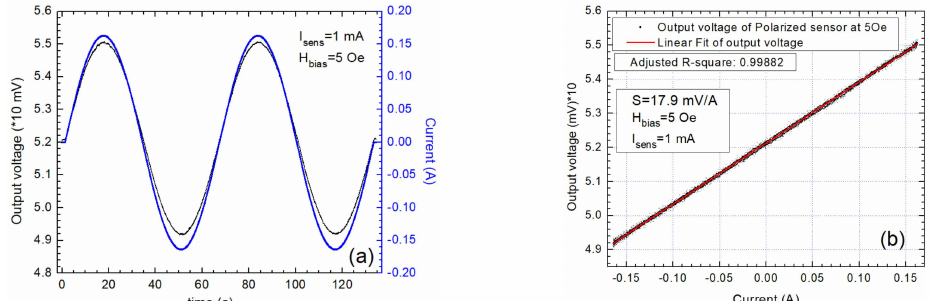
Figure 8. Output characteristics when the sensor AA003-02 is biased at 5 Oe: ( a ) Comparison between the input current and the output voltage wave forms; ( b ) the output voltage as a function of the applied current through the current trace; the sensitivity is 17.9 mV /